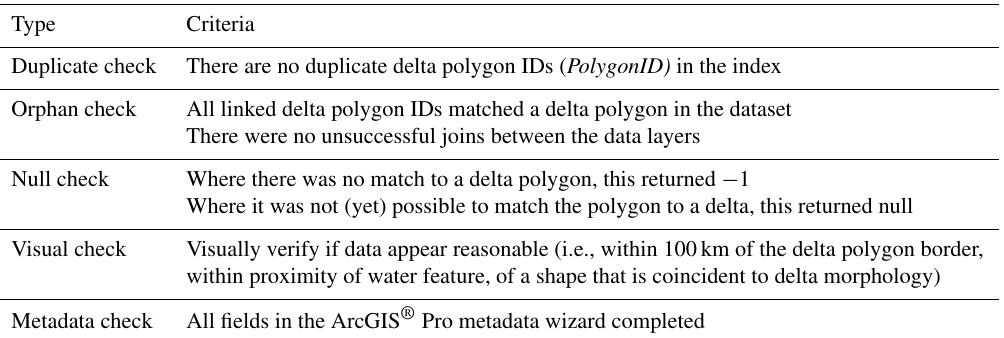
Figure 3. Interactive browsing interface to openDELvE built using the ArcGIS Online platform. Area of focus is the Ganges-Brahmaputra delta, Bangladesh. Data content as per openDELvE version 1.0. available publicly at: http://opendelve.eu (last access: 1 October 2022). Table 4. Categories and criteria for the data validation performed on the